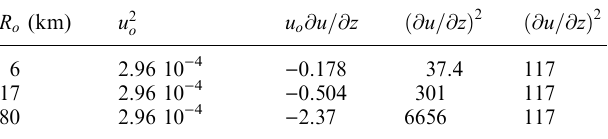
Table 1. Numerical coe(cid:129)cients of the four terms of (15) with (cid:97) (cid:136) 1 : 5 (cid:14) ; # (cid:136) 1 : 5 (cid:14) , and (cid:68) R (cid:136) 150m (the parameters used for the WSMR radar) at typical ranges in the troposphere, stratosphere, and mesosphere. Each term is identified by its remaining variables R o